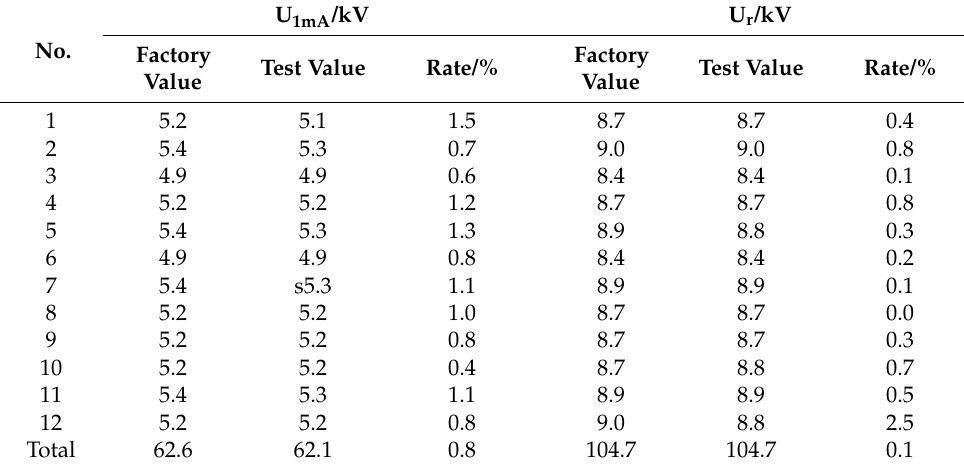
Table 3. Electrical performance test of